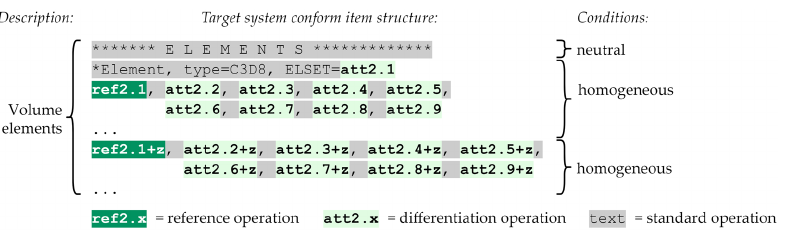
Figure 13. Target system (Z88) conforms to the item structure of the element set blocks.